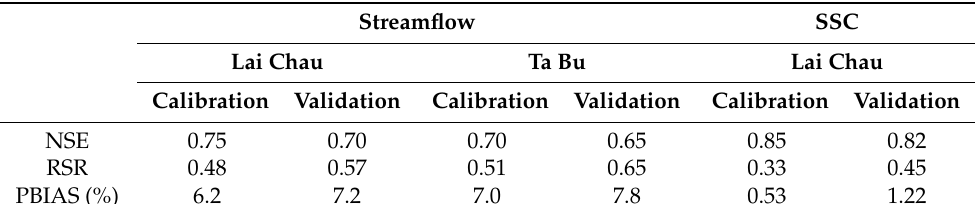
Table 4. Evaluation of BTOPMC and NSRC model simulations during the baseline period for the catchments controlled by the Lai Chau and Ta Bu stations in the DRB.